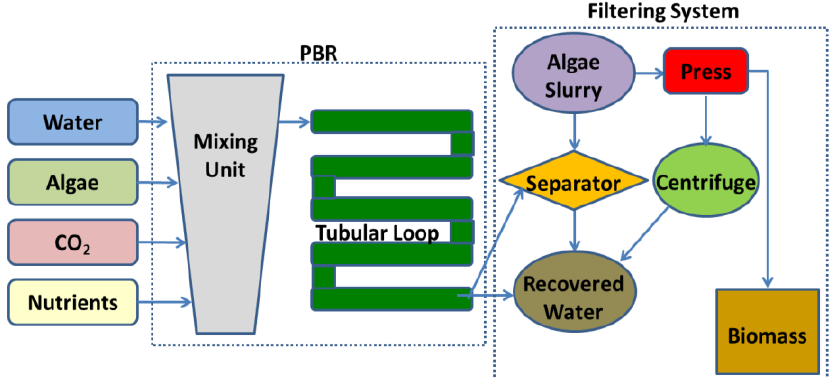
Figure 2. Schematic of a tubular PBR for outdoor